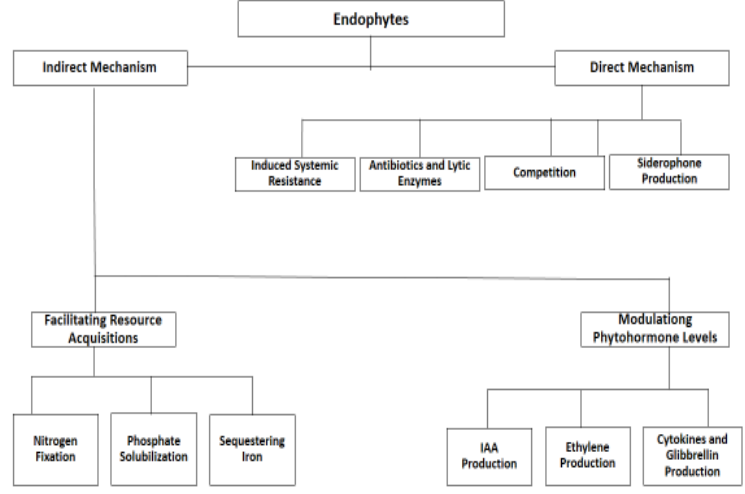
Figure 2: Various Mechanisms of How Endophytes Assist in Plant Growth